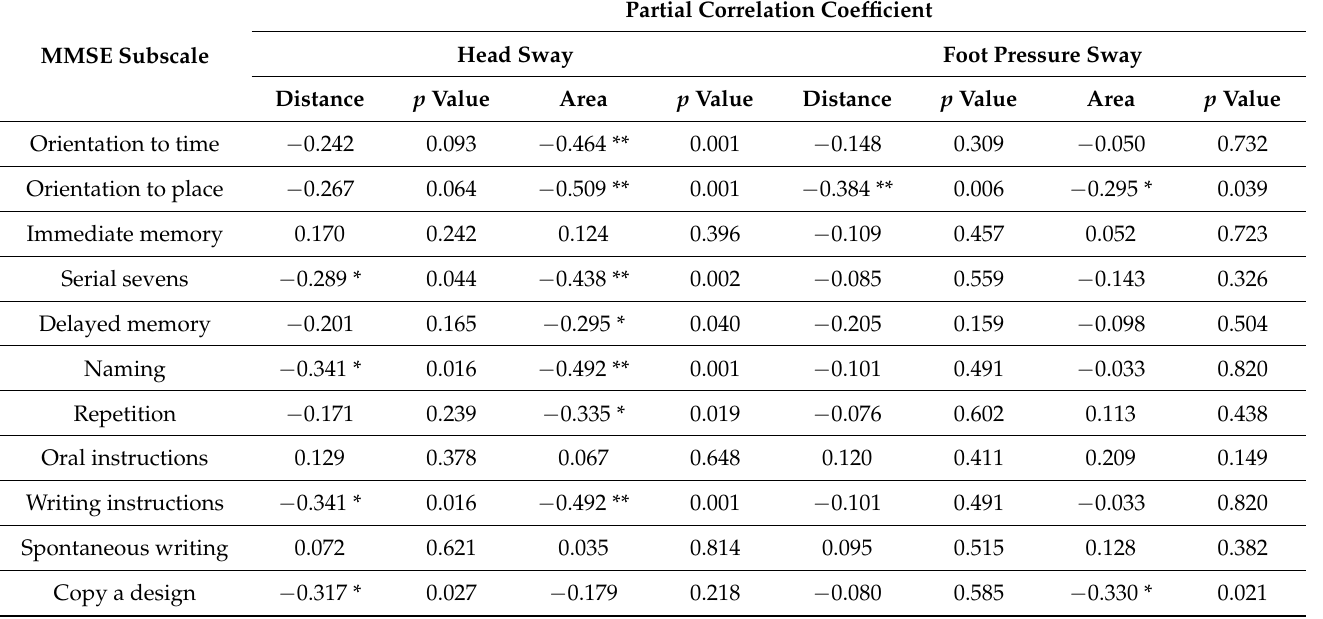
Table 2. Relationship between MMSE subscale and the sway test result in one-leg sway test (EO).